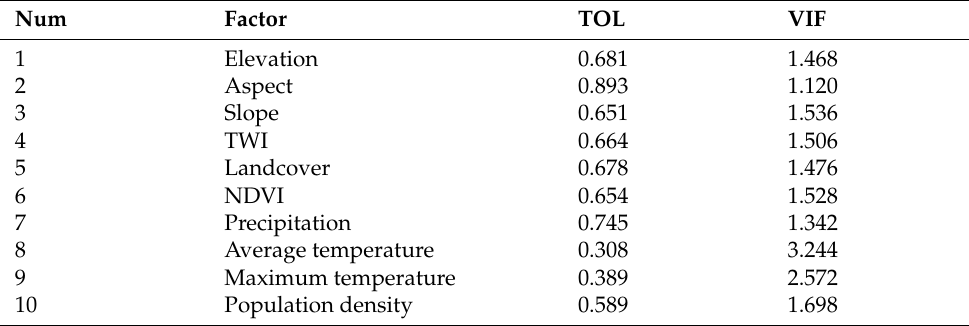
Table 1. Results of multicollinearity